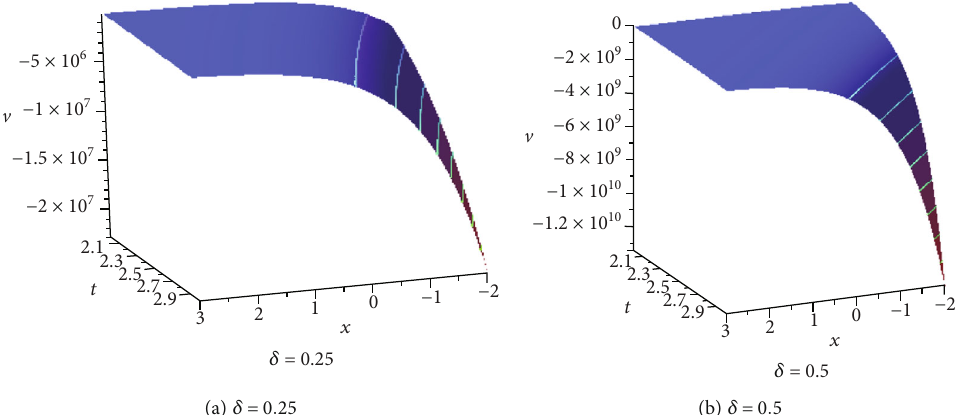
ffiffiffiffiffi p 17 /2 : (a) curvy surface for fractional order, (b) comparatively straight surface for